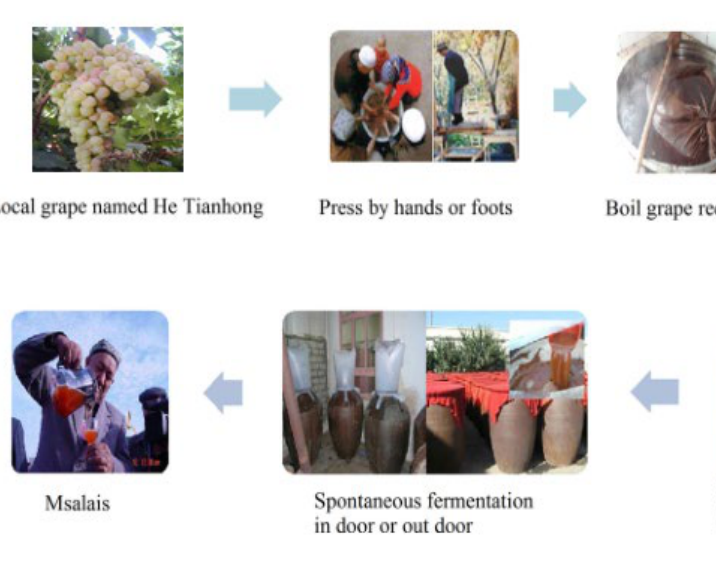
Figure 1. Traditional winemaking processes of Msalais.